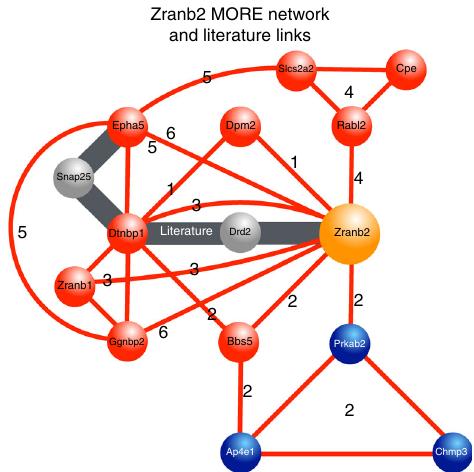
Fig. 7 Zranb2 MORE network. Validation of predicted gene functions based on six shared MORE sets and functional links from literature (further explanation see